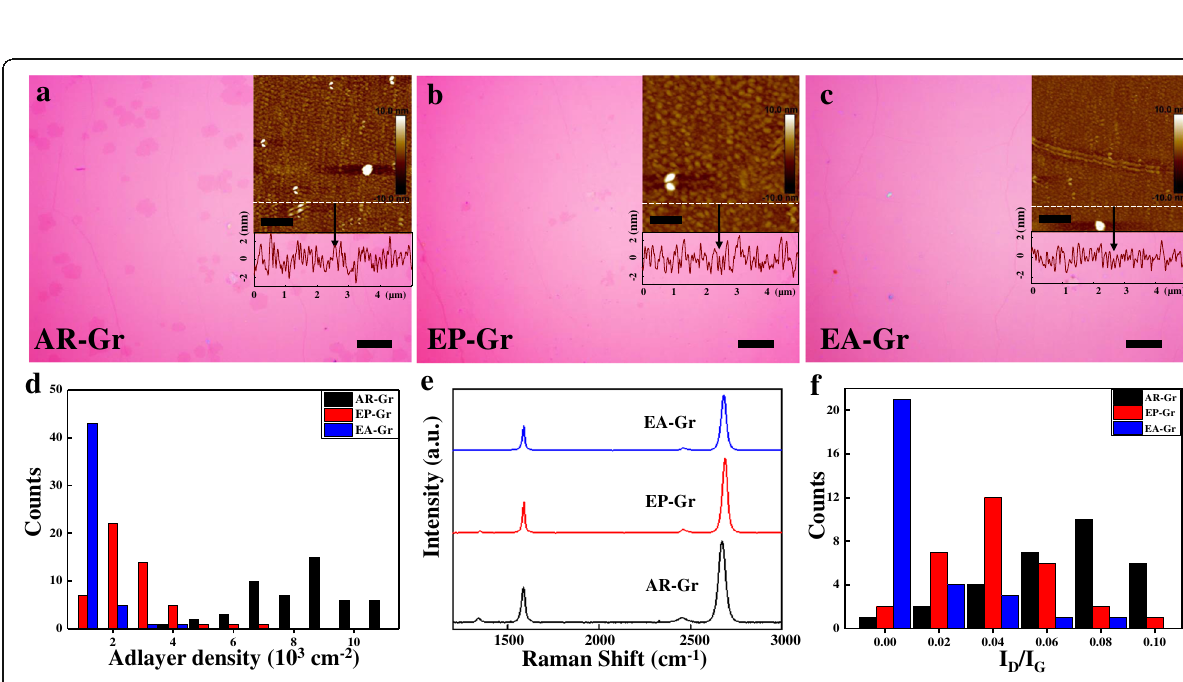
Fig. 4 OM images of transferred graphene films grown on a AR-Cu, b EP-Cu, and c EA-Cu. Scale bars, 10 μ m. (AFM images and amplitude spectrum corresponding to each transferred graphene, inset upper right corner. Scale bars, 1 μ m.) d Histogram statistical graph of graphene adlayer density grown on AR-Cu, EP-Cu, and EA-Cu. The adlayer density is calculated by randomly taking a region with an area of 120 × 90 μ m 2 and then counting the adlayers within the region. e Raman spectra of transferred graphene grown on AR-Cu, EP-Cu, and EA-Cu, respectively. f Histogram statistical graph of I D / I G in Raman spectra of graphene grown on AR-Cu, EP-Cu, and EA-Cu